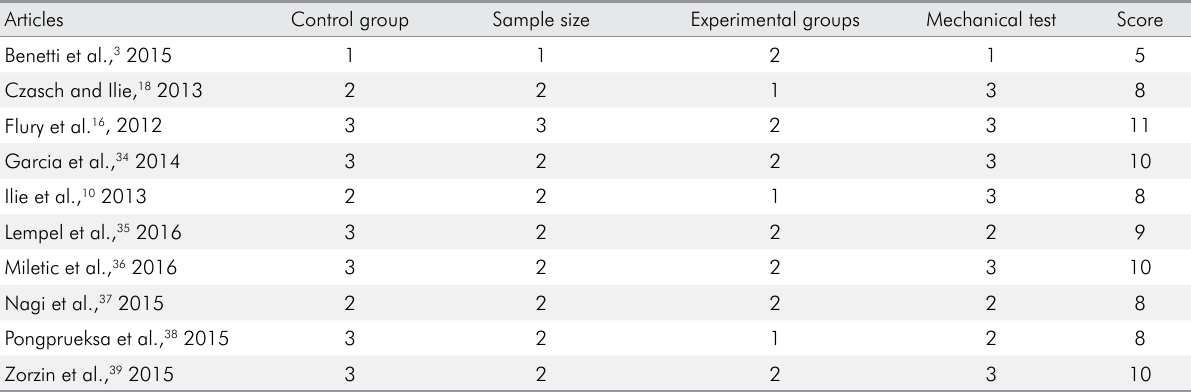
Table 4. Quality assessment scores concerning study design: study design (maximum score = 11 points).